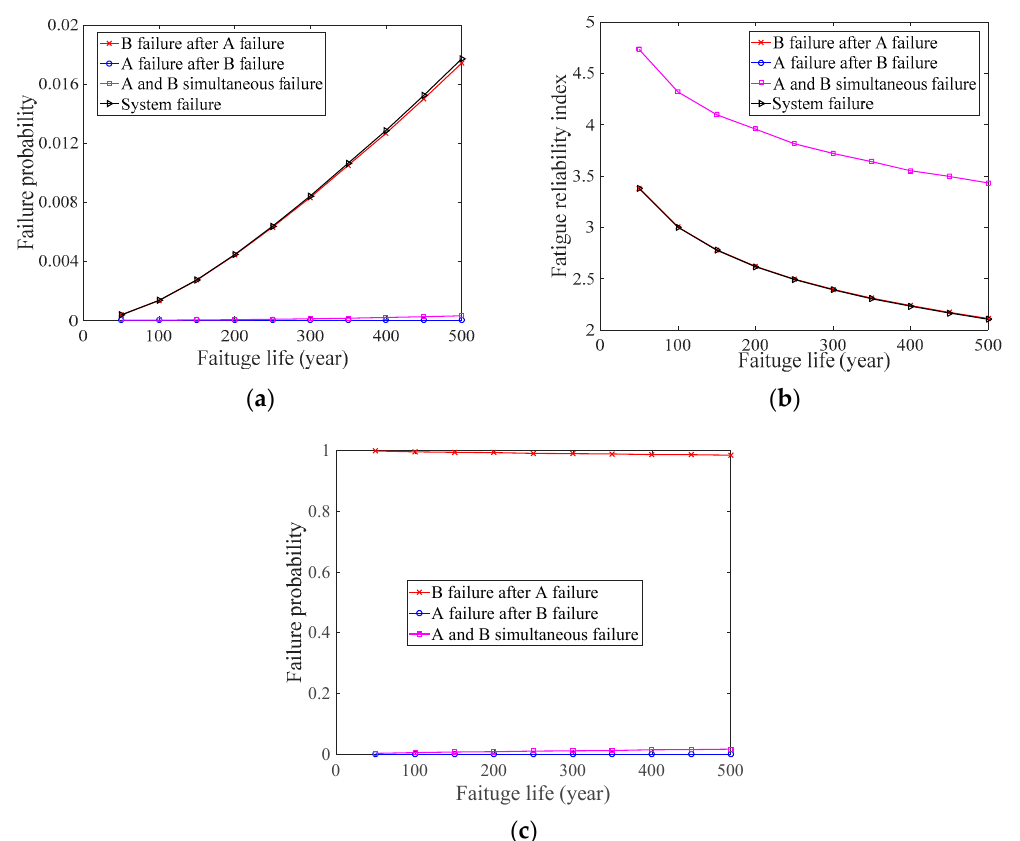
Figure 3. Numerical case study 2. ( a ) Fatigue probability of the welds and system; ( b ) Fatigue reliability index of the welds and system; ( c ) Bayesian inference.